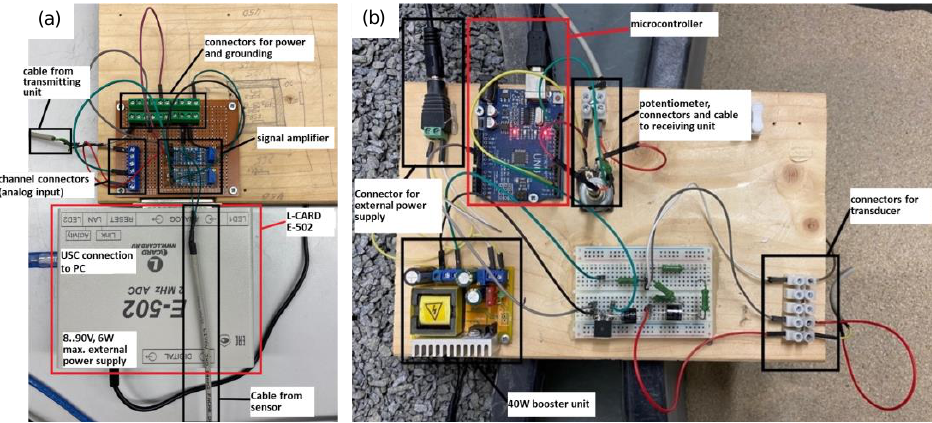
Figure 2. ( a ) Receiving unit with LCARD E-502 system, ( b ) Transmitting unit with microcontroller and booster unit.